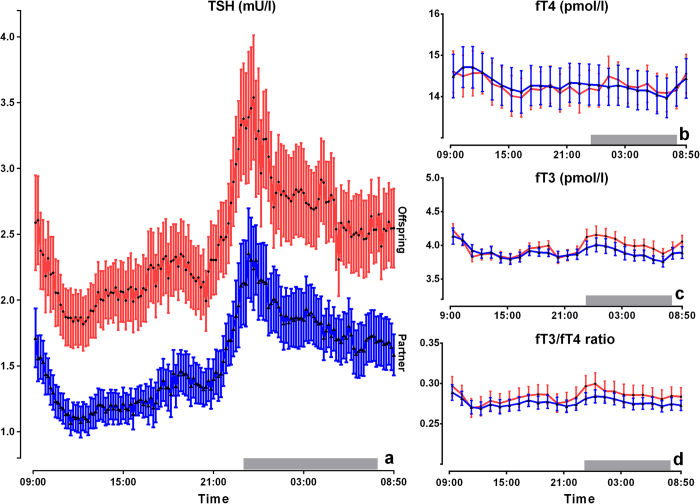
Twenty-four hour profiles of TSH, fT4, fT3 and fT3/fT4 ratio in offspring from long-lived families and partners.In all the panels, data points represent means with standard error of the mean. The red lines depict 20 offspring and the blue lines depict 18 partners. (a) Ten minutes measurements of TSH. Hourly measurements of (b) fT4 (c) fT3 (d) fT3/fT4 ratio. The grey bars represent lights-off periods (from 23:00-08:00).